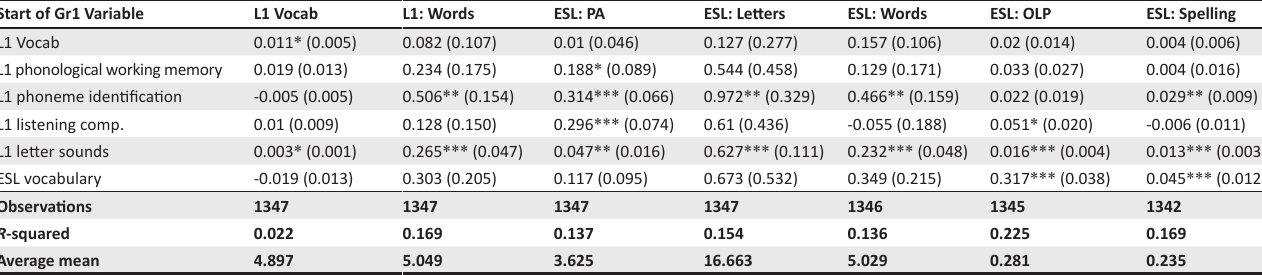
TABLE 4: Regression coefficients and standard errors of start of Grade 1 variables as predictors of end of Grade 1 variables. Start of Gr1